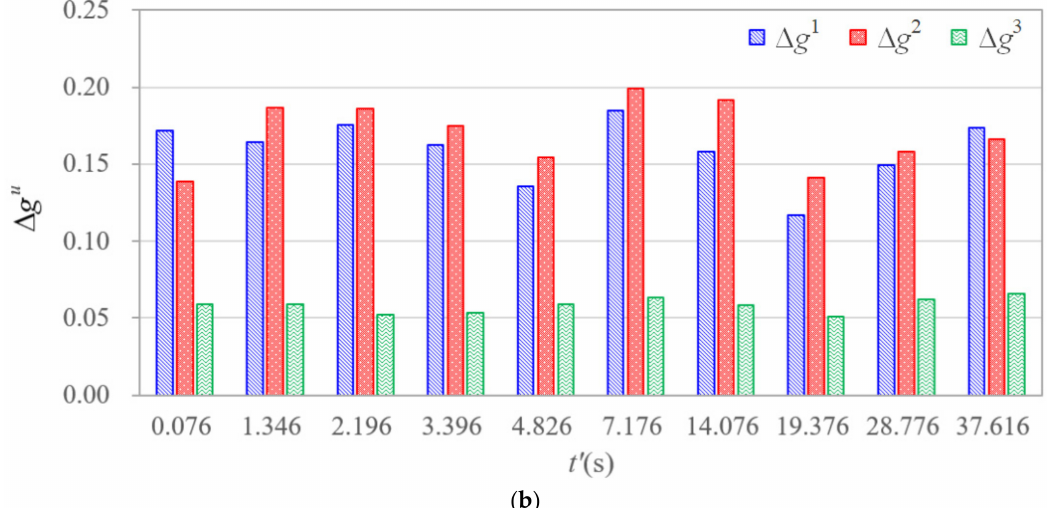
Figure 17. Relative errors of time–frequency parameters of energy consumption distribution of main cutting force of the milling cutter, ( a ) relative errors of energy consumption distribution of scheme 1, ( b ) relative errors of energy consumption distribution of scheme